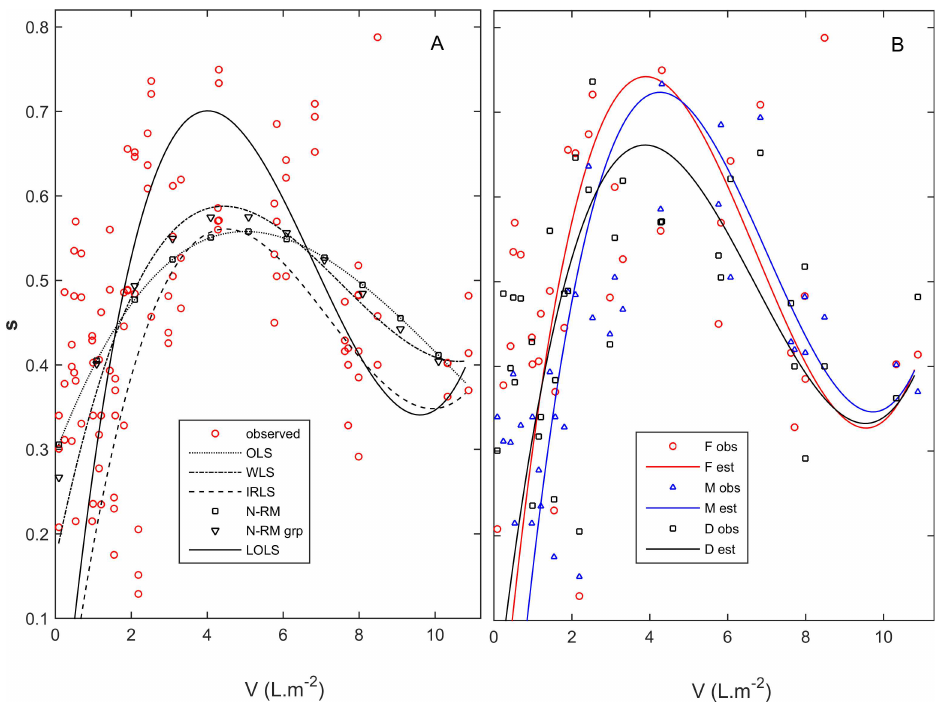
Fig 1. Linear-in-the-parameters regressions to estimatethe survival (s) dependency on population density (V). A: all stages pooledtogetherfor an estimationby (OLS) Ordinary Least Squares,(WLS) WeigthedLeast Squares, (IRLS) Iterative Re-weightedLeast Squares, (N-RM) maximum likelihood estimationiterated by Newton-Raphson Method (grp) with data grouped,(LOLS) or Linear-in-the-parameters ObliqueLeast Squares. B: estimationby LOLS independently for (F) females, (M) males, and (D) diploids.